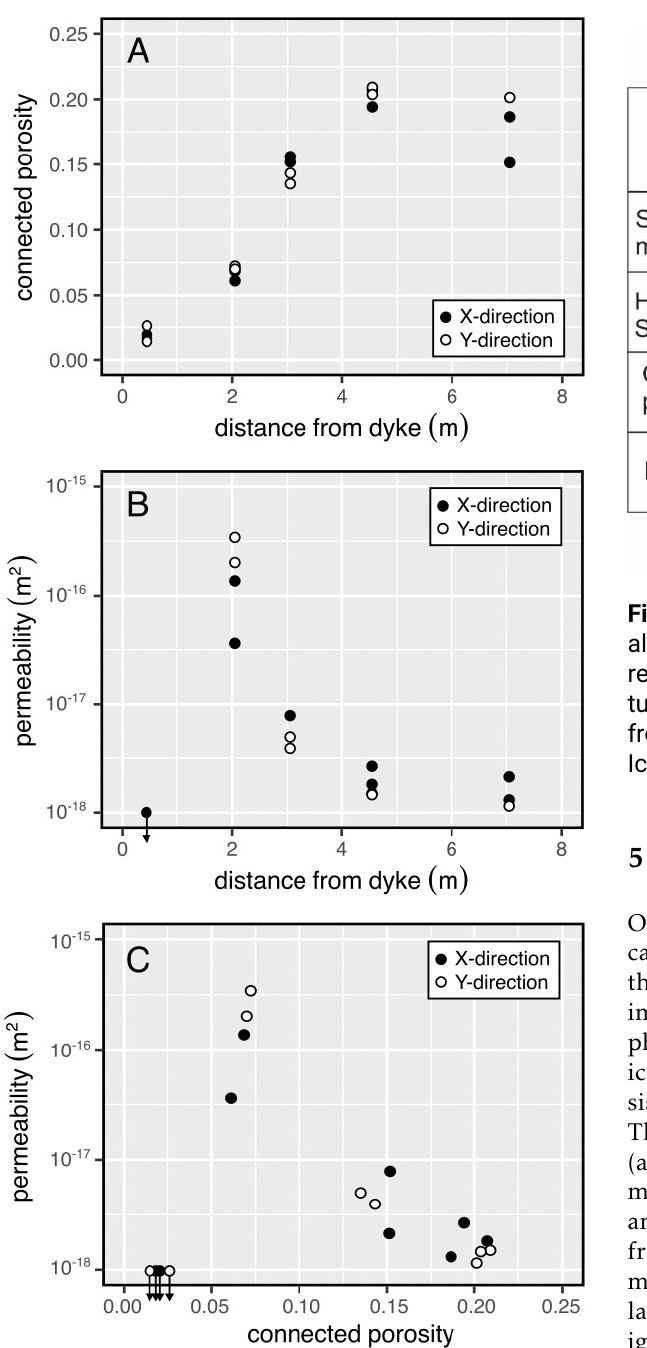
Figure 7: Laboratory measurements of connected porosity [A] and permeability [B] as a function of dis- tance from the dyke margin. [C] Laboratory measure- ments of permeability as a function of connected poros- ity. Black symbols – samples cored in the X-direction (approximately perpendicular to dyke margin). White symbols – samples cored in the Y-direction (approxi- mately parallel to dyke margin). The samples with the lowest porosity, 0.45 m from the dyke margin, were too low to be measured in our permeameter ( (cid:28) 10 − 18 m 2 ), indicated by the arrow. The experimental error on the measurements of porosity and permeability are (cid:28) 1 % and <1 %, respectively, and so the error is encapsulated by the symbol size. Data available in Table 3.